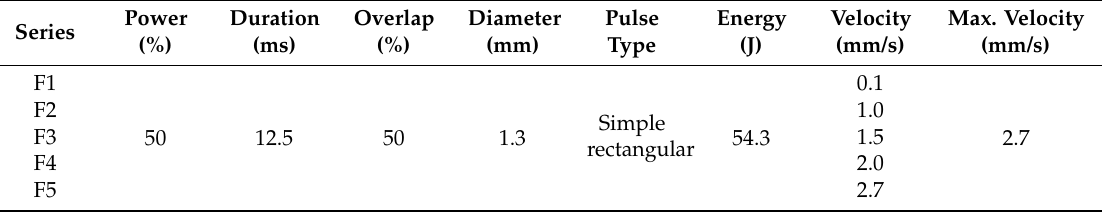
Table A6. Experimental plan for the effects of velocity on weld penetration.